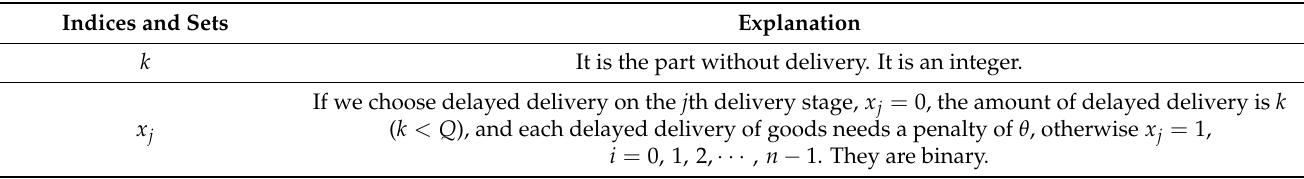
Table 3. Decisions Variable